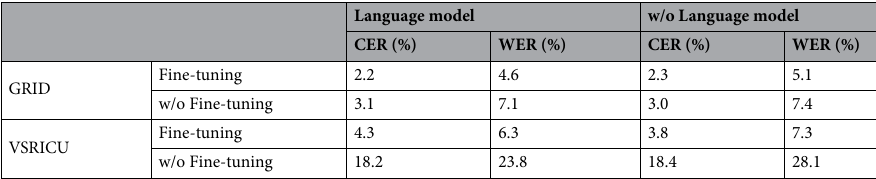
Table 2. Best character (CER) and word (WER) error rates on the GRID and VSRICU dataset with and without using the spell language model after CTC decoding. “w/o Fine-Tuning” indicates the STT model not being fine-tuned with the predicted audio features from the AFE.